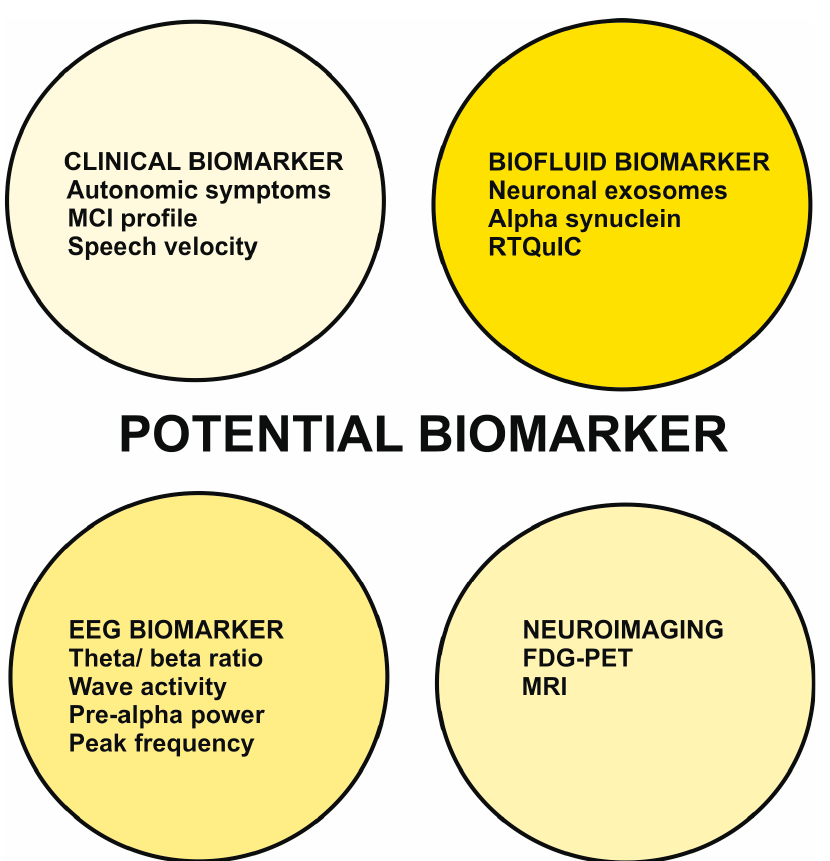
Figure 1. Potential biomarker of prodromal dementia with Lewy bodies with an MCI-onset. Abbreviation: FDG-PET = fluorodesoxyglucose positron imaging, MCI = mild cog-